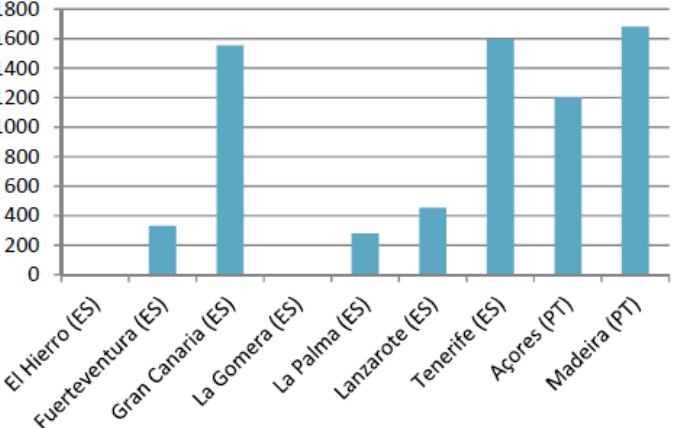
Figure 4. Number of airlines connections from Spanish and Portuguese ORS—adapted from EU— European Parliament [44].